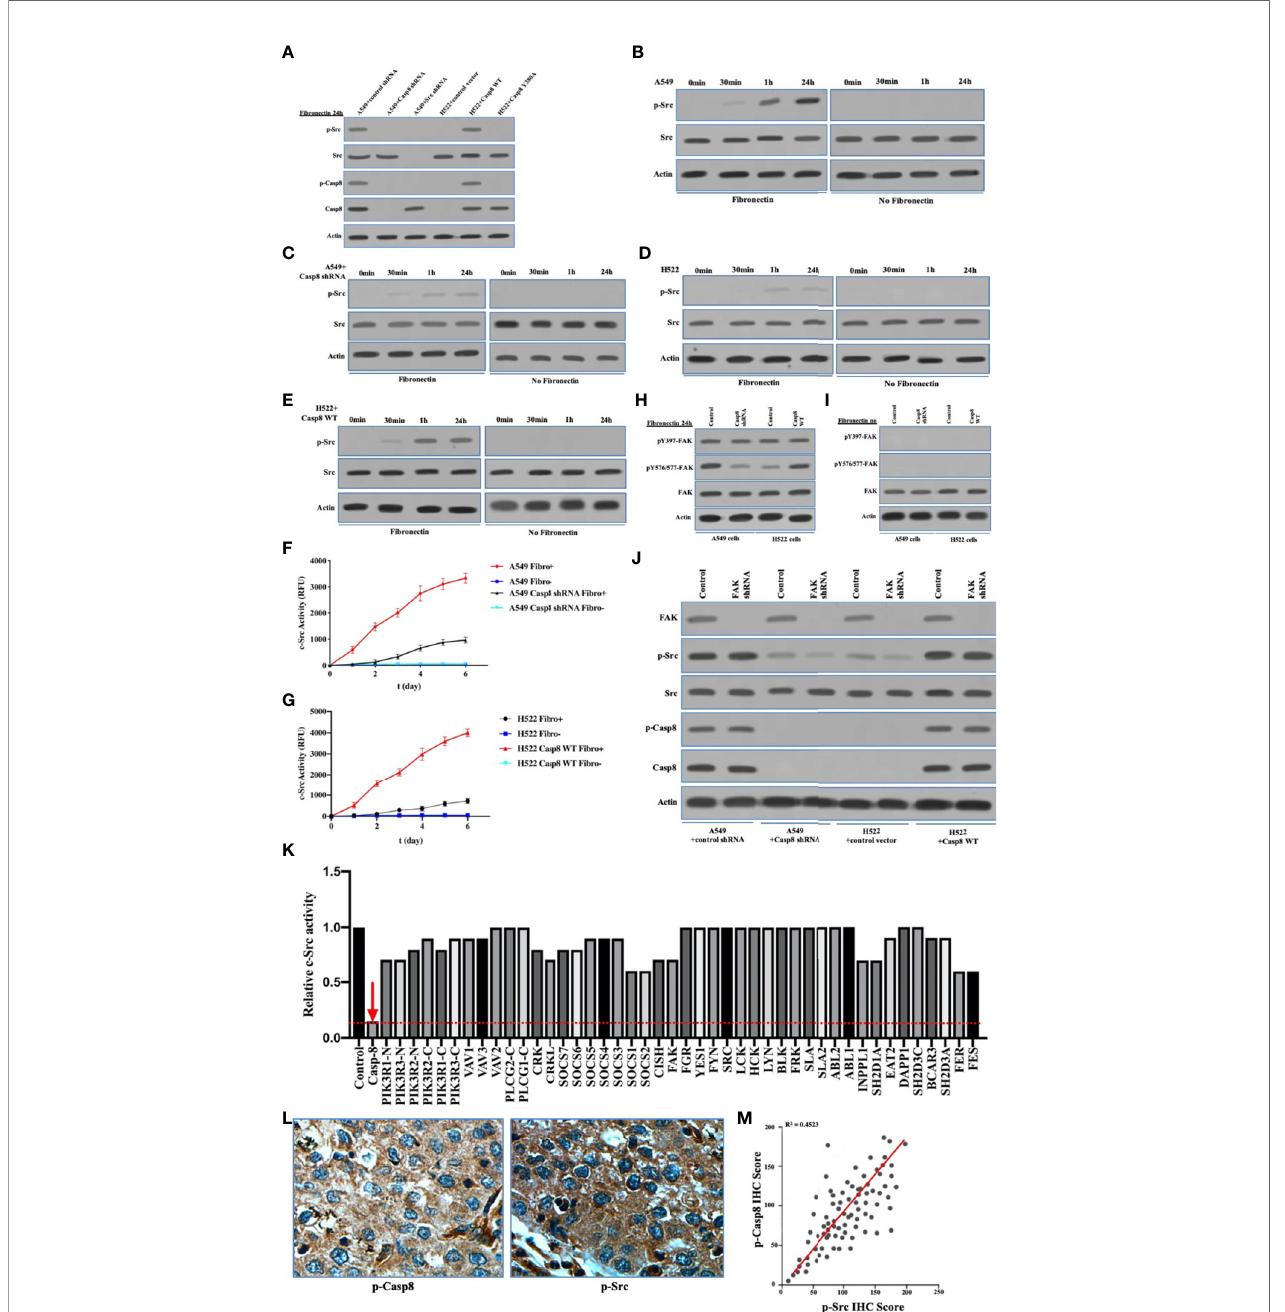
FIGURE 2 | c-Src was overactivated in lung adenocarcinoma dependently on Caspase-8. (A) Immunoblotting analysis of p-Src, c-Src, p-Casp8, Caspase-8 and b - actin in A549 + control/Src/Casp8 shRNA and H522 + control vector/Casp8 WT/Casp8 Y380A attached on fi bronectin for 24 h. (B – E) Immunoblotting analysis of p- Src, c-Src and b -actin in A549 + control (B) /Casp8 shRNA (C) and H522 + control vector (D) /Casp8 WT (E) attached on fi bronectin or not for 24 h. (F, G) A549 cells with a lentiviral delivery of either control shRNA (F) or Casp8 shRNA and H522 cells with an adenoviral delivery of either control vector or Casp8 WT (G) attached on fi bronectin or not were in the presence of a c-Src-speci fi c fl uorescent substrate, and fl uorescence was recorded as the function of time (* p < 0.05). (H, I) Immunoblotting analysis of pY397-FAK, pY567/577-FAK, FAK and b -actin in A549 + control/Casp8 shRNA and H522 + control vector/Casp8 WT attached on